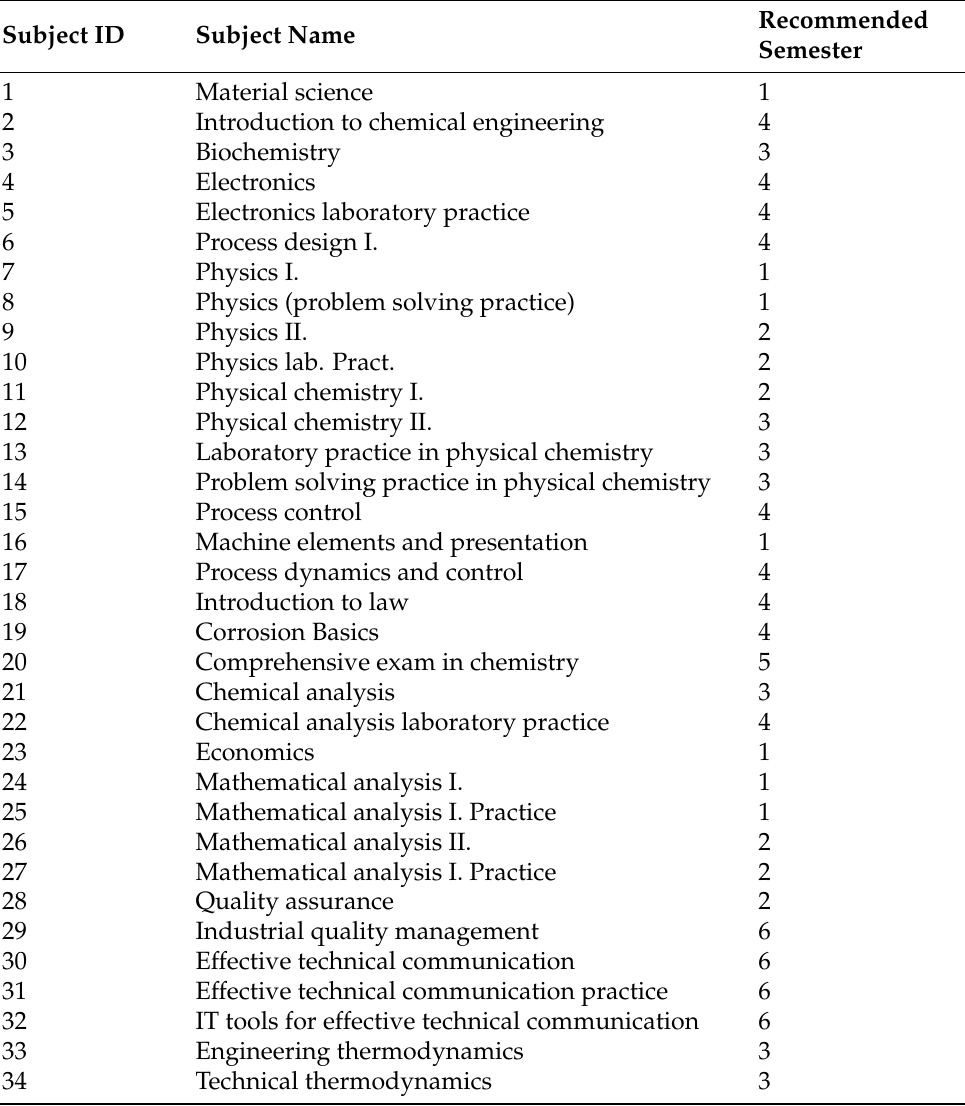
Table A1. Summary of the Identifiers, Names Used in the Study and the Number of Recommended Semesters of Subjects According to the Sample Curriculum part